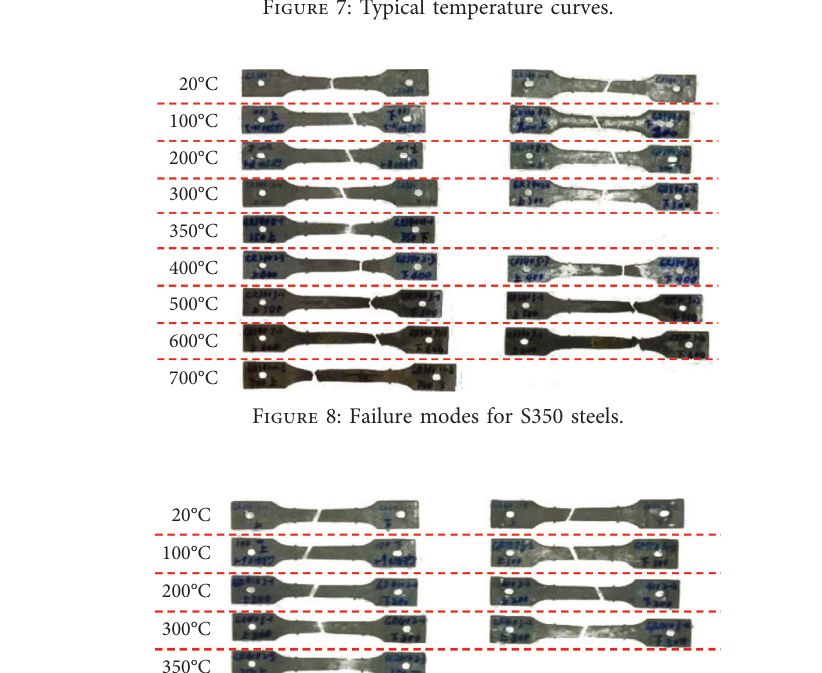
Figure 7: Typical temperature curves.